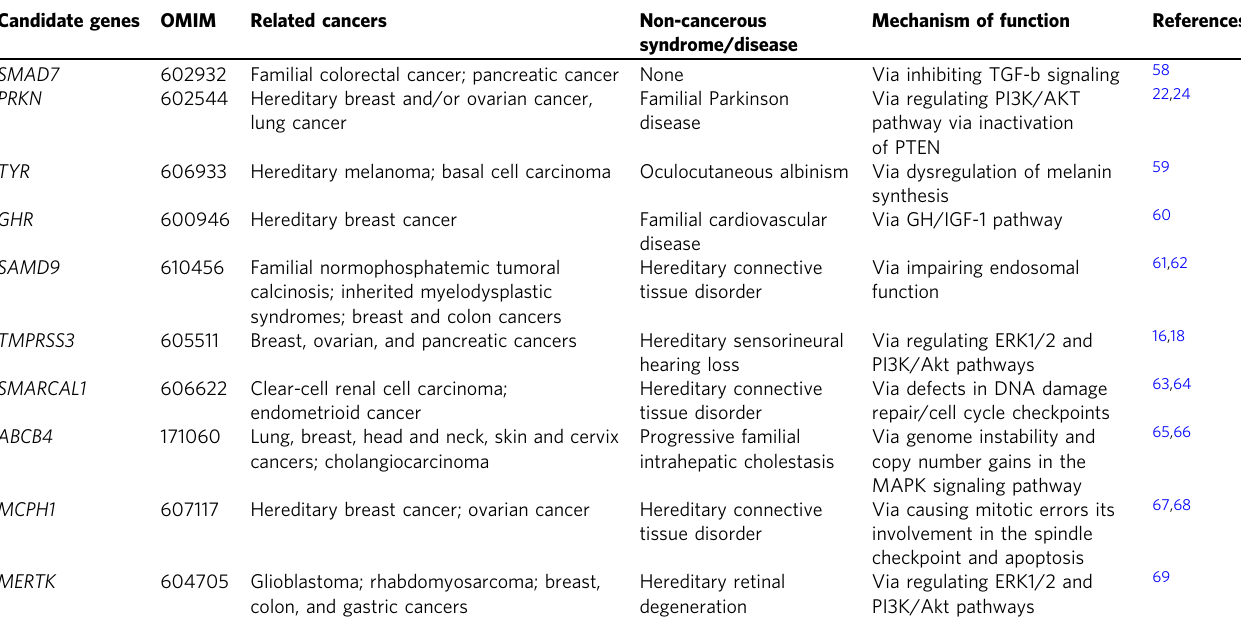
Table 3 Ten examples of candidate genes and their associations with